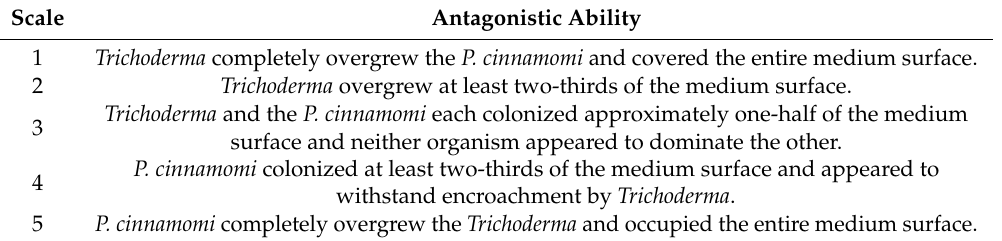
Table 2. Trichoderma strain antagonism evaluated in vitro using Bell’s scale [39], considering the invasion of the